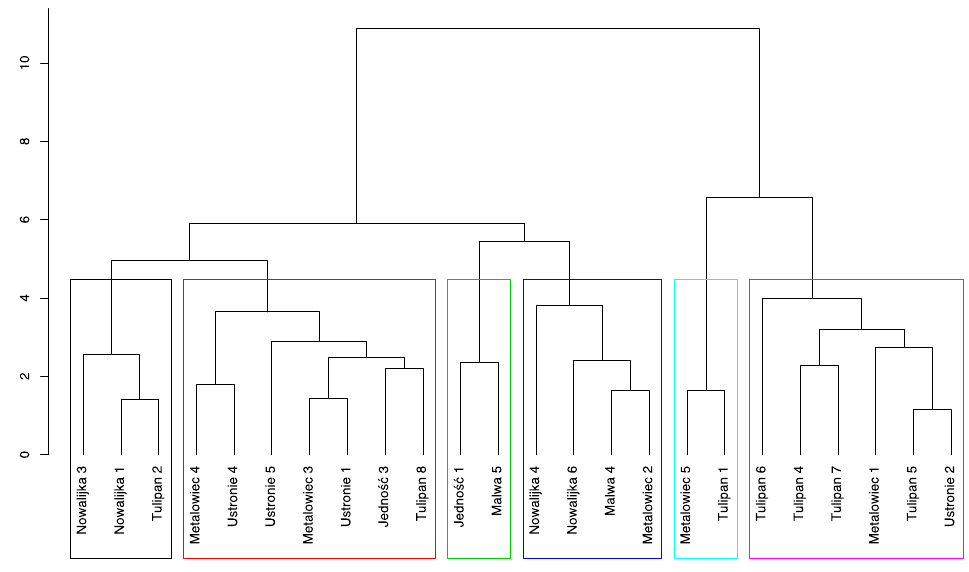
Figure 5. PCA relationship among studied allotment plots in respect to root parameters.